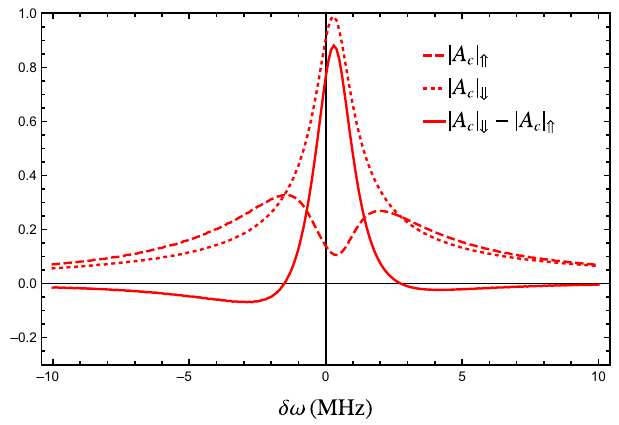
FIG. 6. Cavity transmission | A c | ⇑ , | A c | ⇓ and readout contrast, | − | A | (cid:2) = 10 μ eV and B | A ⇓ ⇑ , for c c point where the red and the second dashed orange line from the left in Fig. 5 intersect, as a function of the probe pulse detuning δω . The remaining parameters are as in Fig.